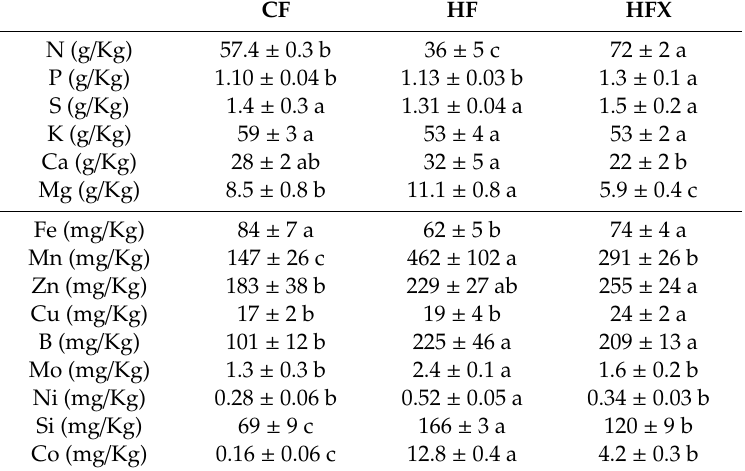
Table 4. Foliar analysis of pepper plants fertigated with nutrient solutions made with conventional fertilization (CF), MCT ® fertilizers (HF) and MCT ® fertilizers plus TX (HFX). Data are represented as the mean ± standard deviation. Di ff erent letters indicate significant di ff erences between treatments ( p < 0.05, n =